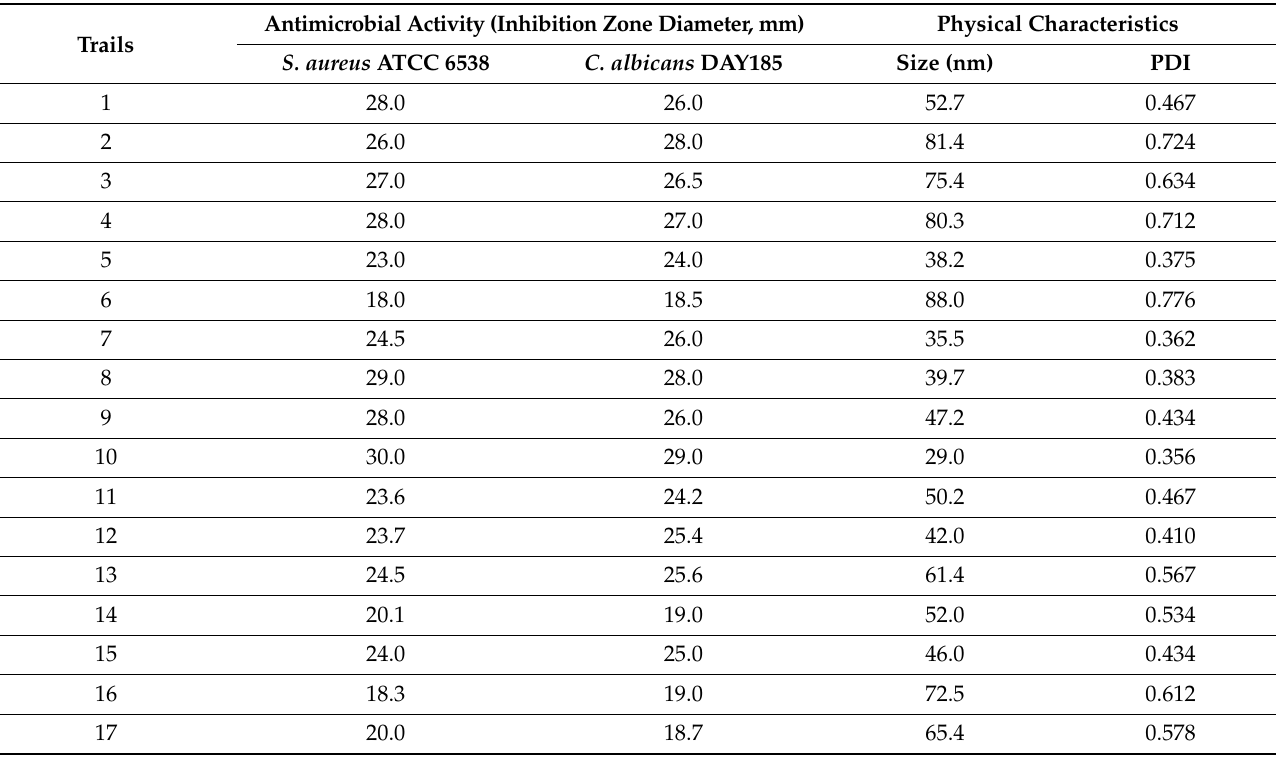
Table 4. Mo-capped AgNP synthesis optimization using Box–Behnken design.